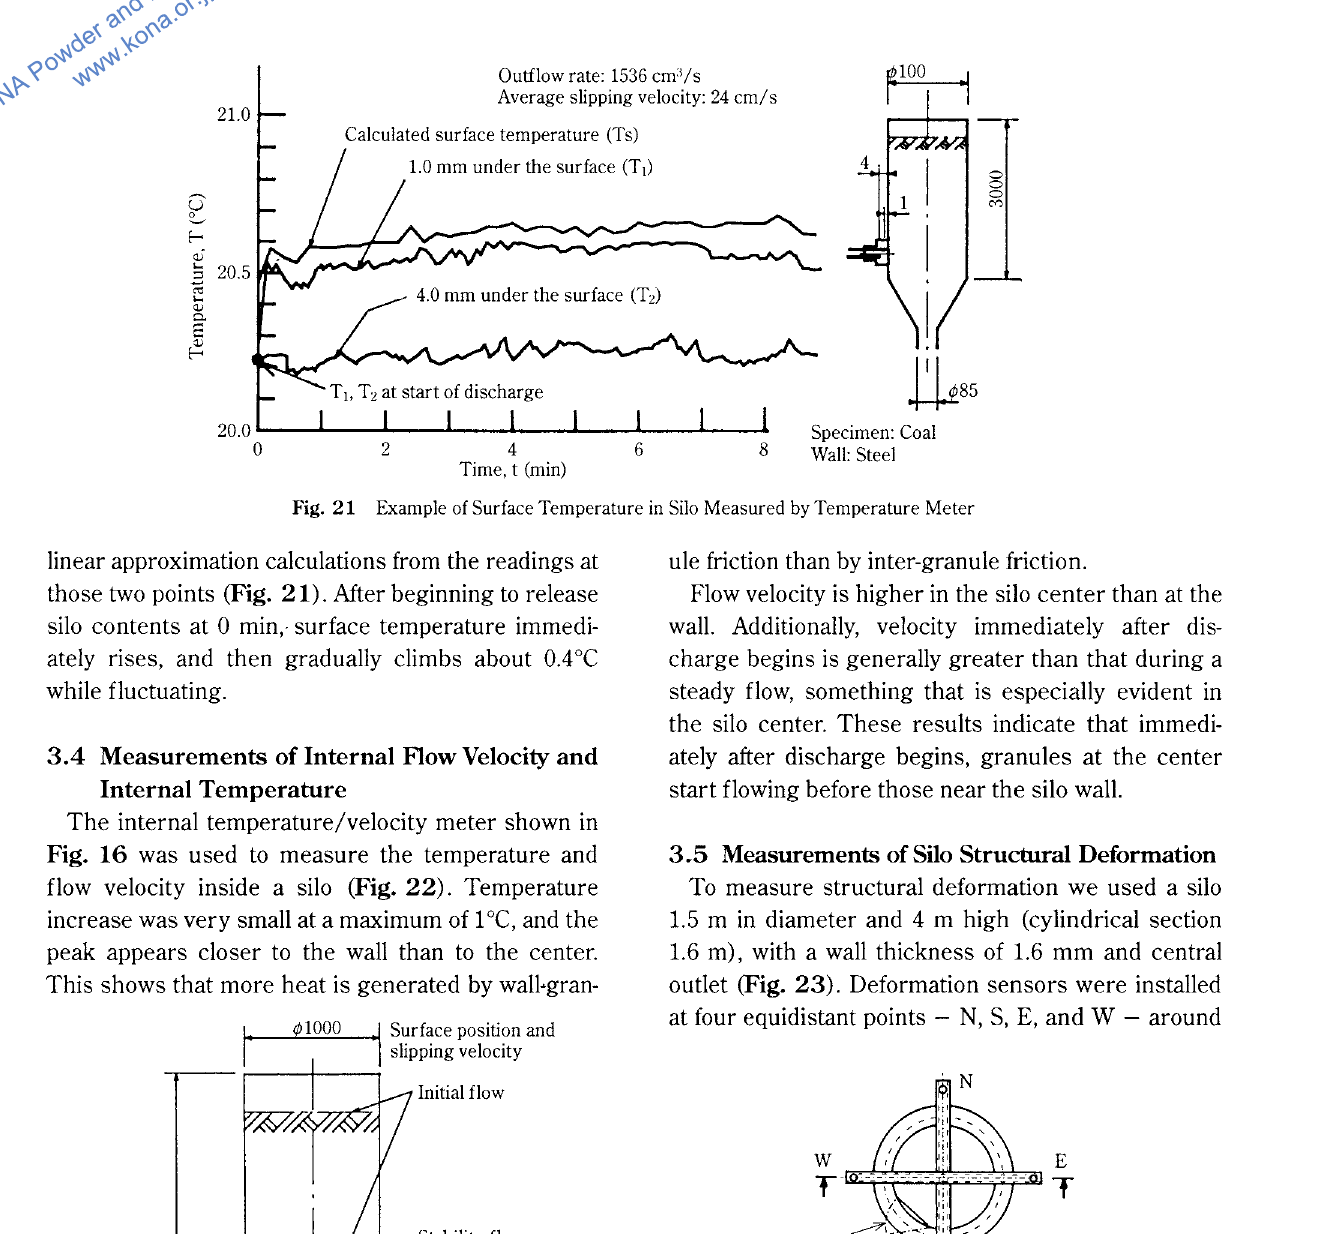
Fig. 23 Method of Measuring Stored Volume in Silo by Deformation